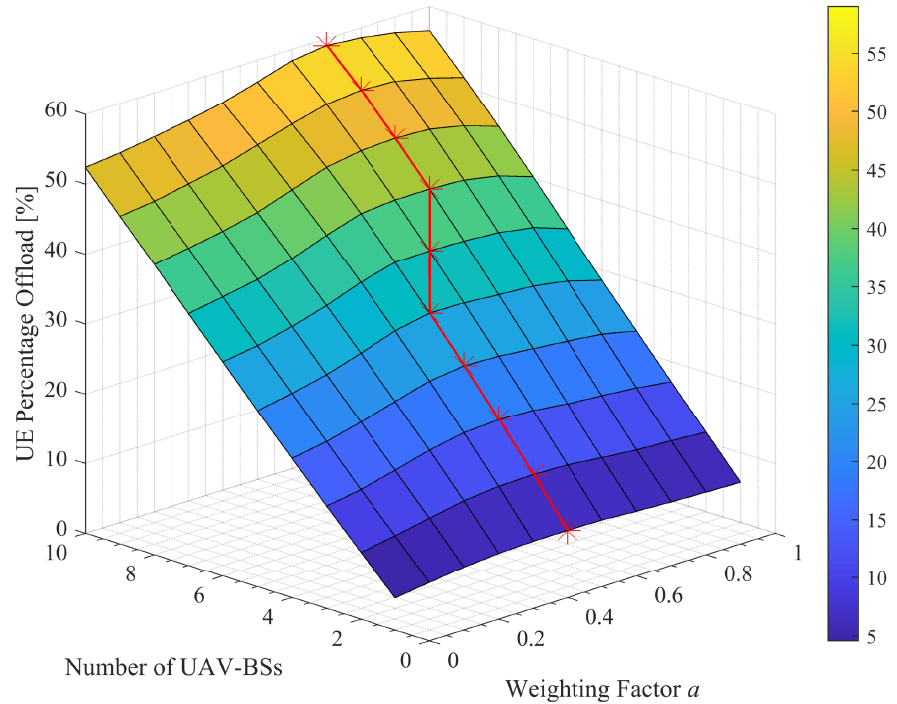
Figure 2. Percentage of UEs offloaded from the MBSs utilizing the UDP method, for different number of UAV-BSs and weighting factor a